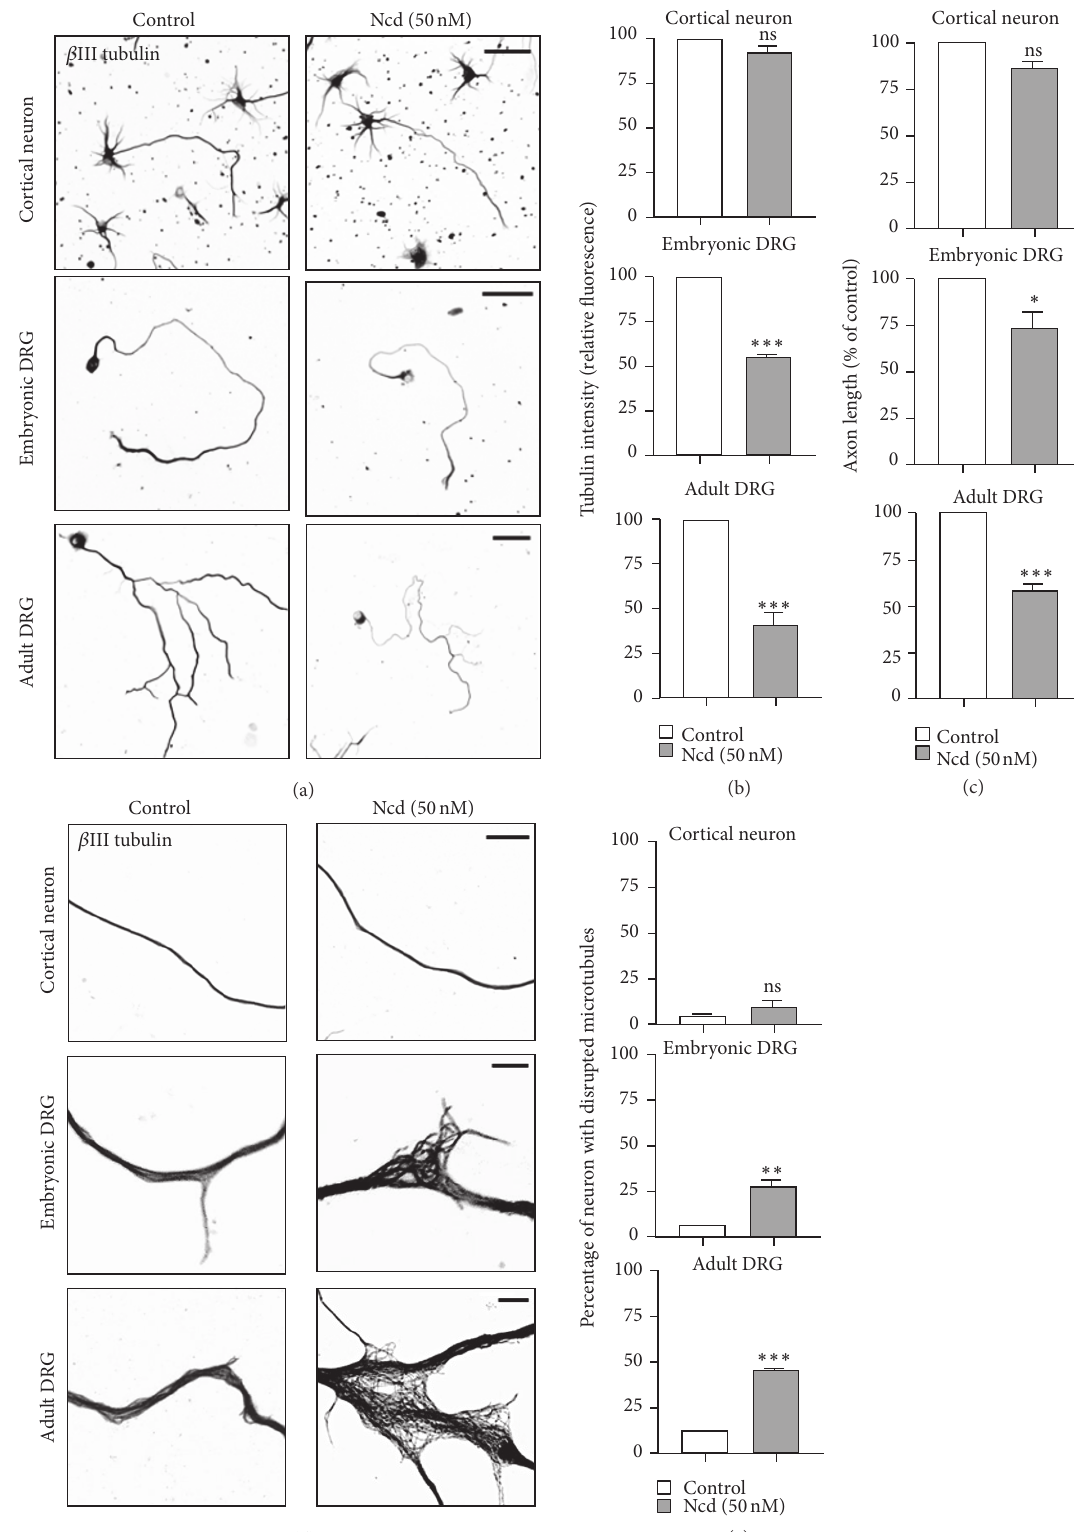
Figure 6: Neurons of different type and age contain MTs that differ in stability. (a–d) Embryonic (E15.5) cortical neurons, embryonic (13.5) DRG neurons, or adult DRG neurons were cultured in the absence or presence of nocodazole (Ncd) (50nM, 1.5 hr) and were immunostained with anti-Tuj1 antibodies. Representative images (a, d) and quantification of fluorescence intensity of 𝛽 III-tubulin immunostaining (b), axon length (c), and percentage of neurons with disrupted MTs (e) are shown. Scale bar, 50 𝜇 m. ∗ 𝑝 < 0.05, ∗∗ 𝑝 < 0.01, and ∗∗∗ 𝑝 < 0.001; ns, statistically not